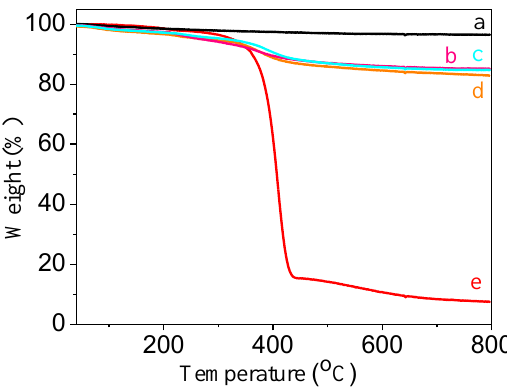
Figure 1. Thermogravimetric analysis (TGA) curves of ( a ) the bare SiO 2 (black line), ( b ) SiO 2 @poly(2-vinyl pyridine)- b -poly(ethylene oxide) (P2VP- b -PEO)_1 (pink line), ( c ) SiO 2 @P2VP- b -PEO_2 (cyan line), ( d ) SiO 2 @P2VP- b -PEO_3 (orange line), and ( e ) P2VP- b -PEO (red line).